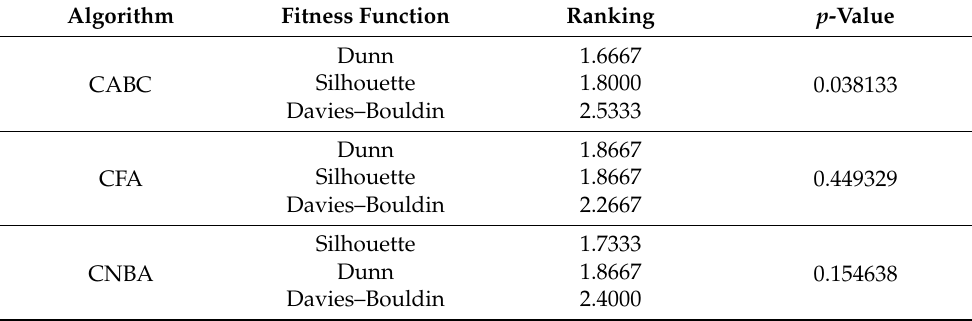
Table 5. Ranking of Friedman test comparing the results of the proposed algorithms with different fitness functions, according to ARI